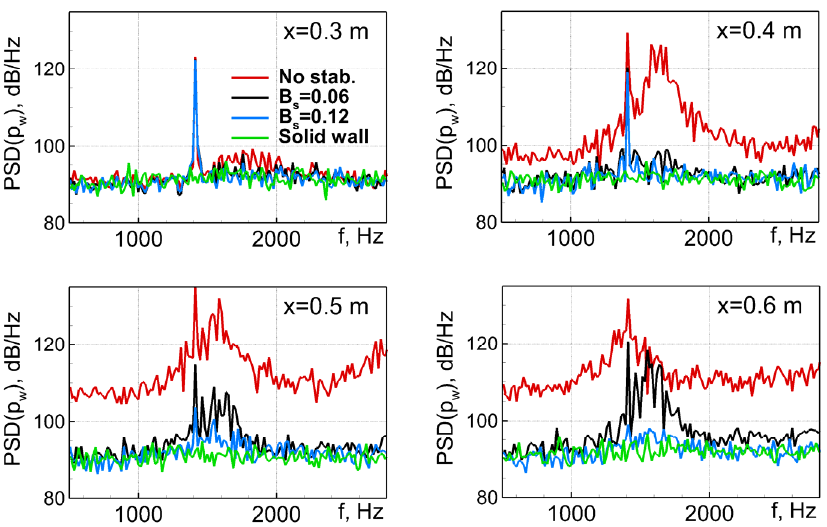
Figure 25. Effect of stabilization (10) and its amplitude parameter B s on the evolution of wall pressure